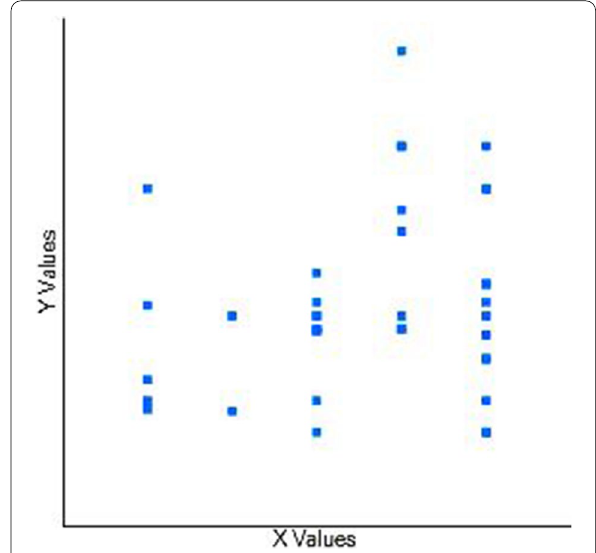
Fig. 5 Pearson’s correlation coefficient, X axis representing sub-site involvement and y axis representing hearing loss in